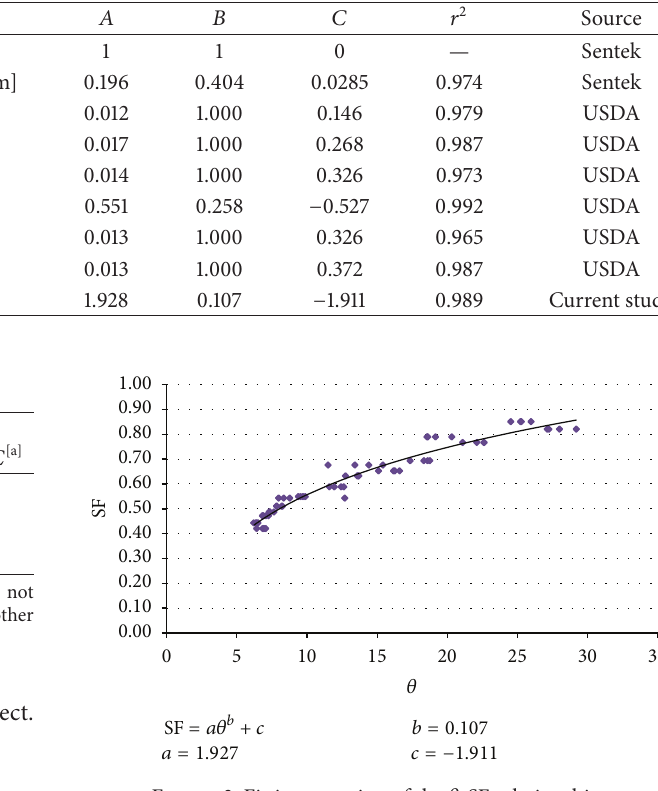
Figure 3: Fitting equation of the 𝜃 -SF